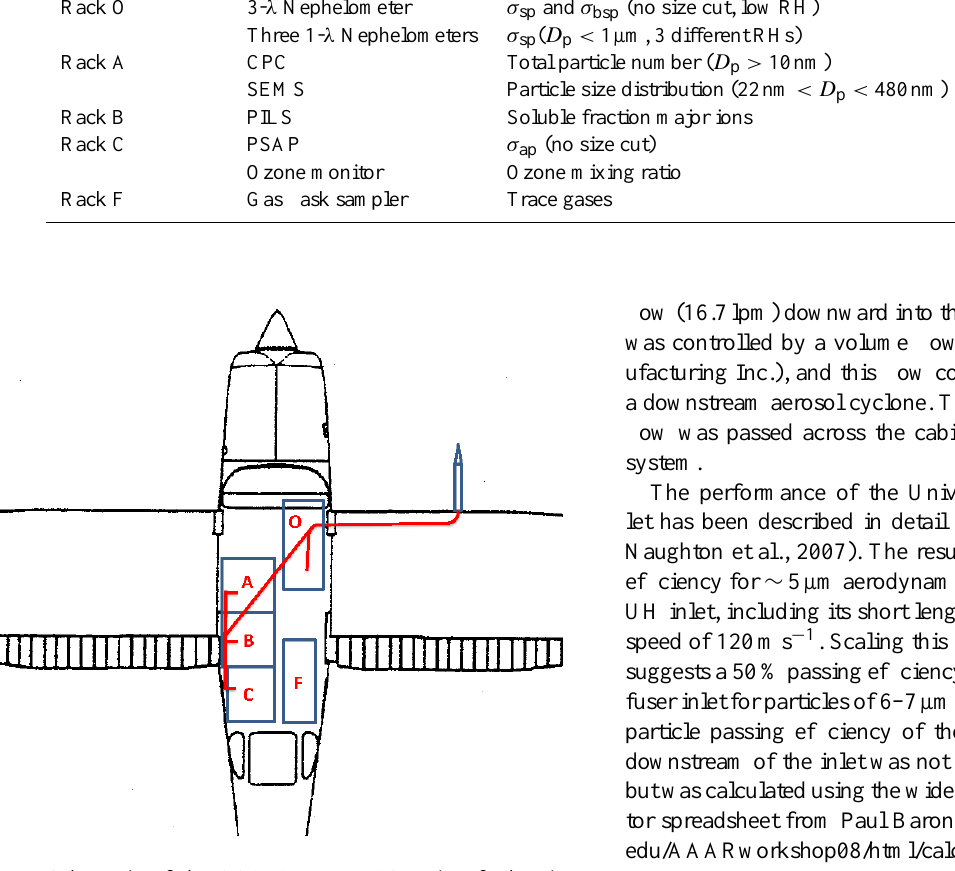
Fig. 1. Schematic of the AAO Cessna T206H aircraft showing aerosol inlet and instrument racks. Main aerosol sample line is shown in red. Lettered areas are described in the text and in Table